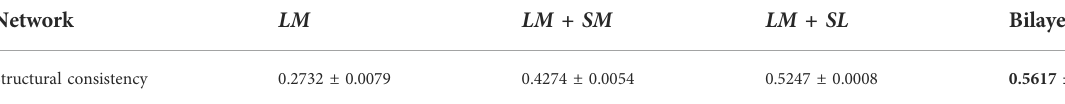
TABLE 1 Structural consistency of four related networks on the lncRNASNP dataset.